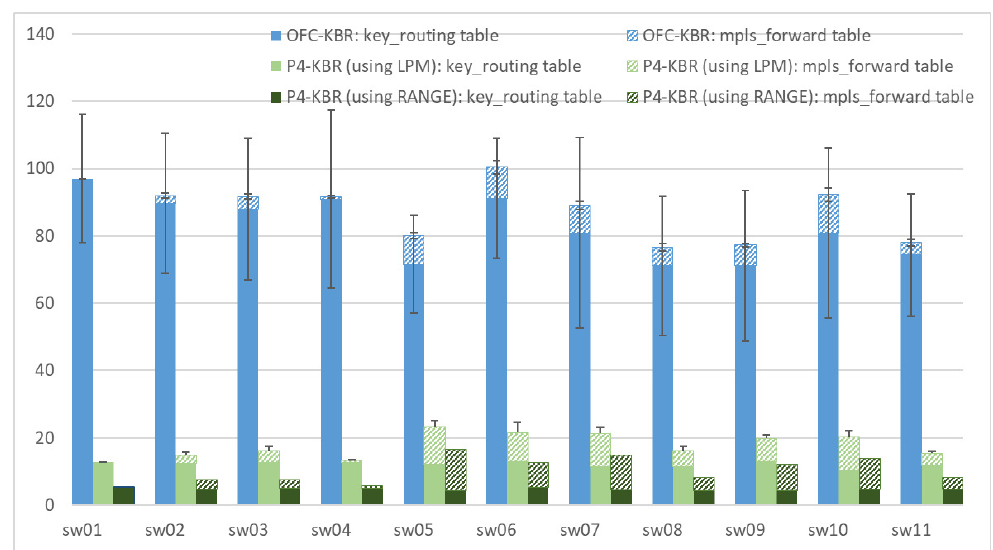
Figure 12. OFC-KBR versus P4-KBR. Occupancy of the device tables: number of entries in the key_routing and mpls_forwarding